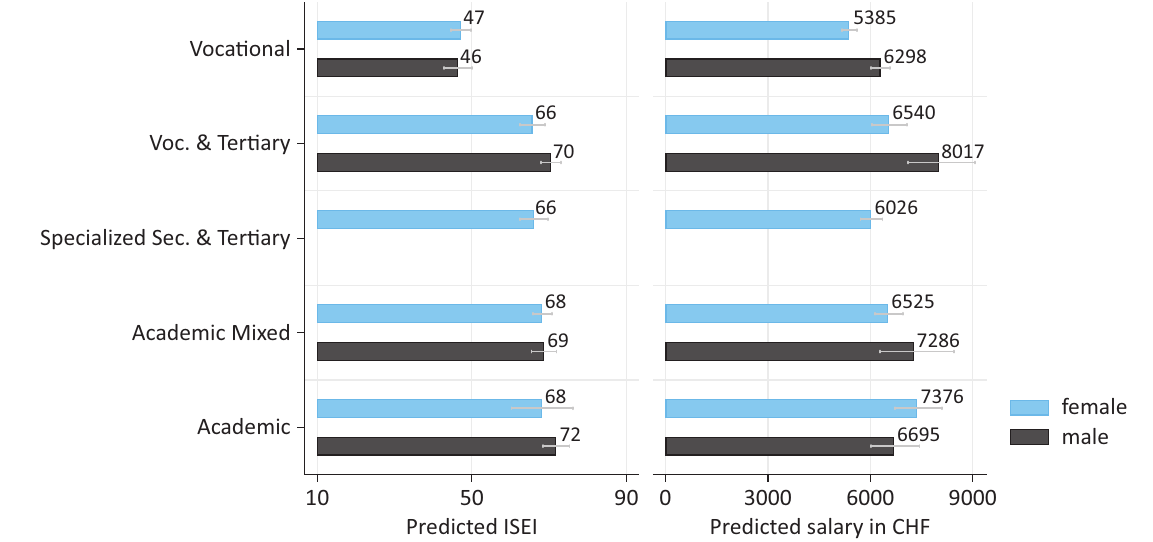
Figure 8. Predicted Social Status (ISEI) and Predicted Salary by Educational Cluster, grey spikes: